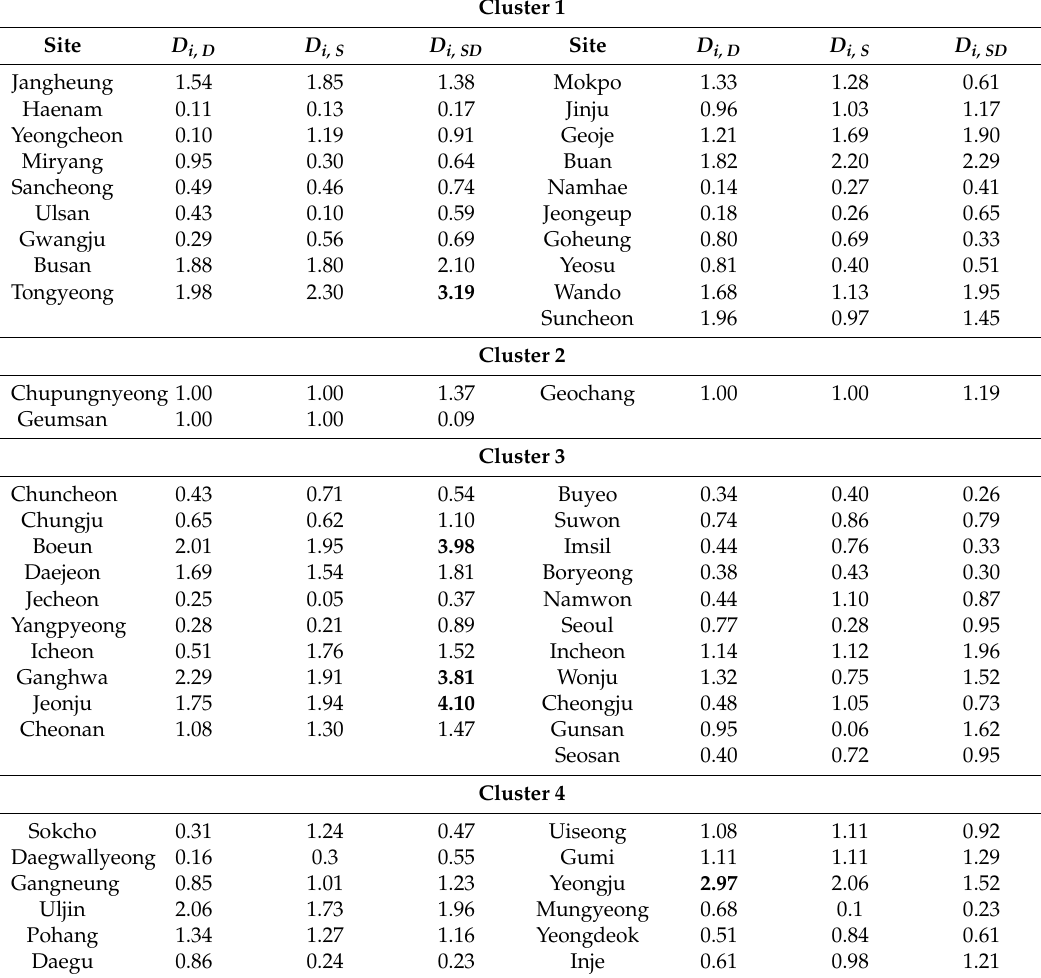
Table 3. Results of univariate and bivariate discordancy measure for SPI-6 at 55 stations across South Korea, using the clusters formed by HCPC algorithm, and bold is selected as discordant sites, D i, D denotes the discordancy for drought duration, D i, S denotes the drought severity and D i, SD denotes the discordancy for both drought duration and